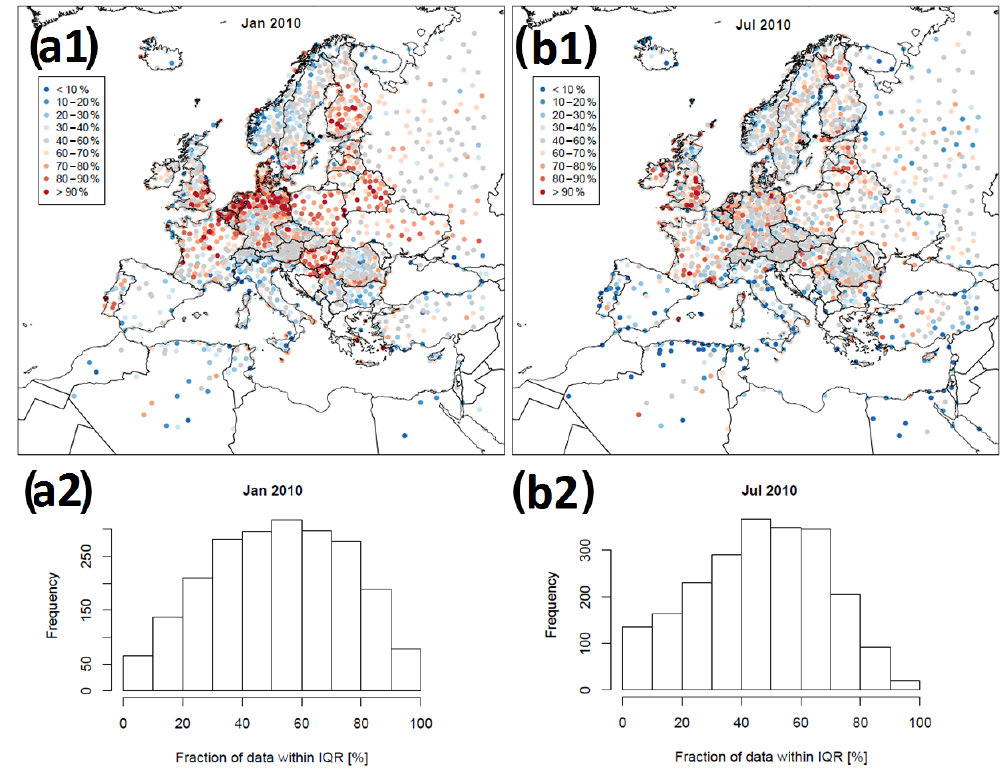
Figure 22. Comparison of cross-validation results with gridded uncertainty estimates for daily mean temperature in January 2010 (a1) and July 2010 (b1) : fraction of interpolated daily data at stations within nearest-neighbor gridded IQR (interquartile range). Blue indicates an underestimation; red indicates an overestimation of the uncertainty. In panels (a2) and (b2) corresponding frequency distributions are